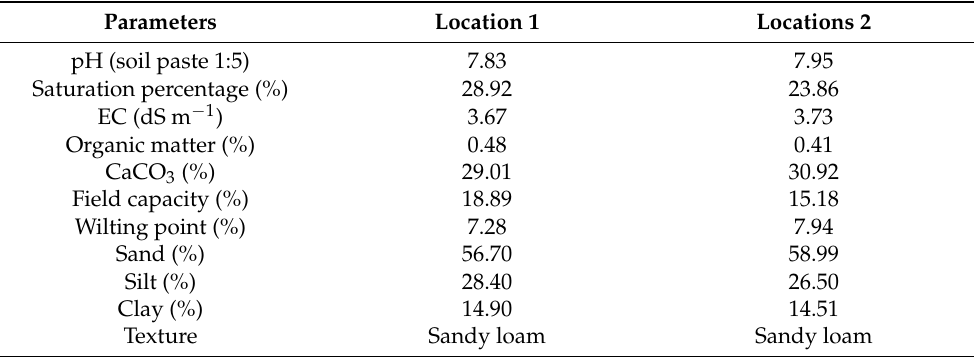
Table 1. Baseline soil physical and chemical properties for the old cultivated soil and virgin soil two locations prior to